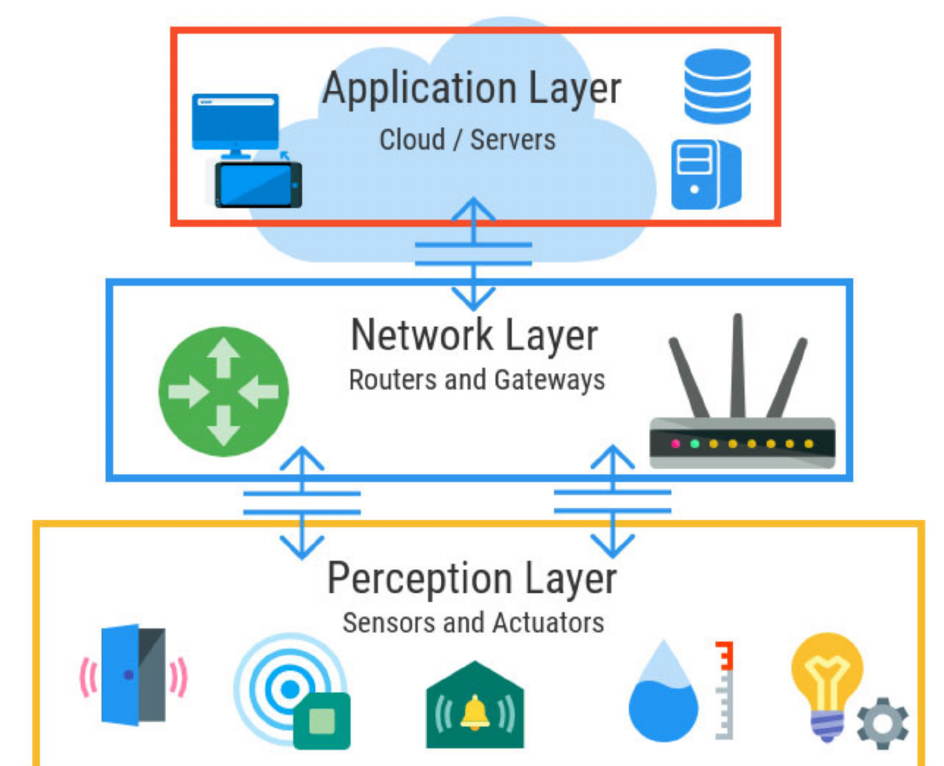
Figure 2. A three-tier